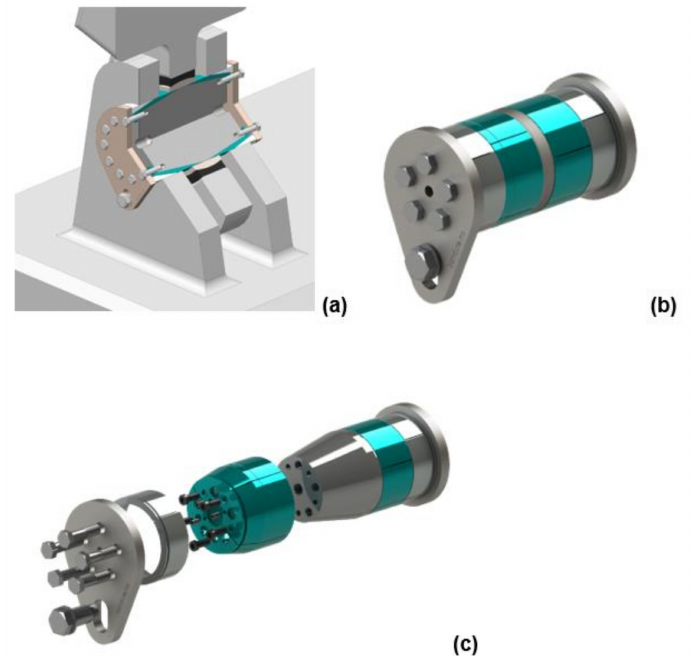
Figure 3. Dual expanding pin with two set of sleeves: ( a ) pin in joint, ( b ) pin assembly and ( c ) exploded